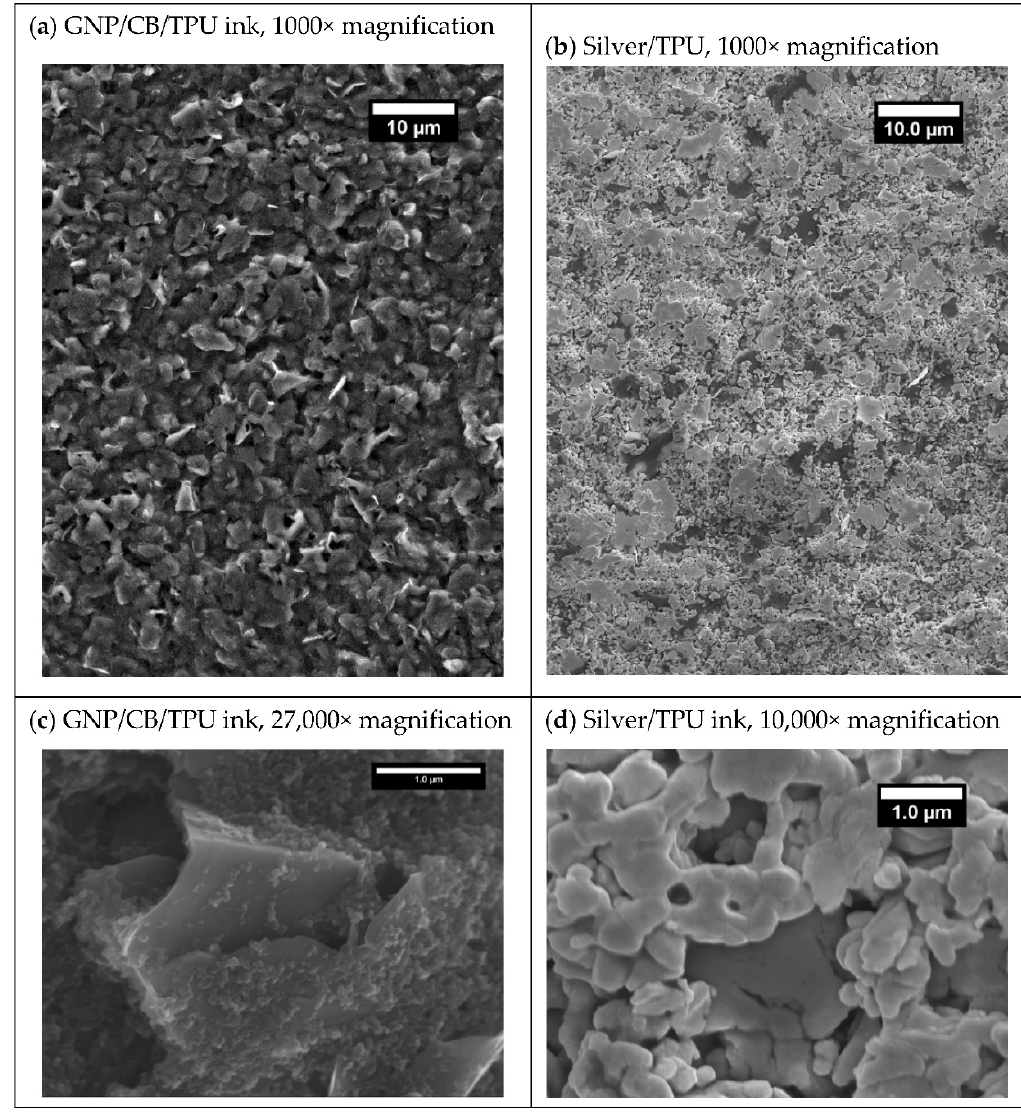
Figure 4. Scanning electron microscope images of ( a ) GNP/CB ink at 1000×, ( b ) Silver flake ink at 1000× ( c ) GNP/CB ink at 27,000×, and and ( d ) Silver flake ink 10,000× magnification.